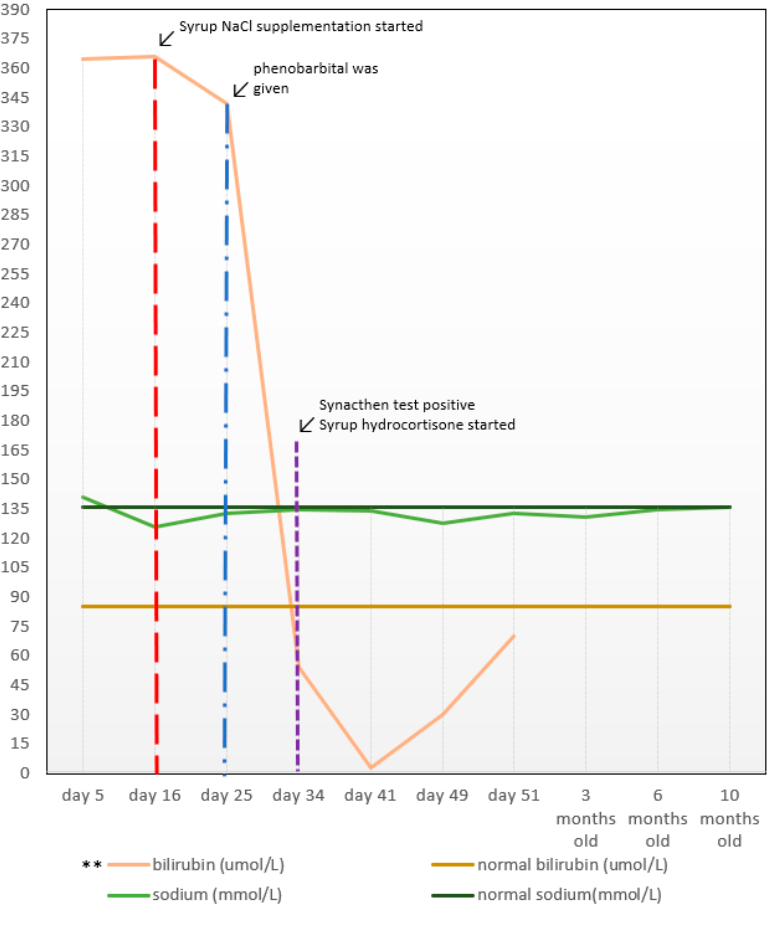
Figure 3. Clinical course of serum bilirubin and sodium levels of the